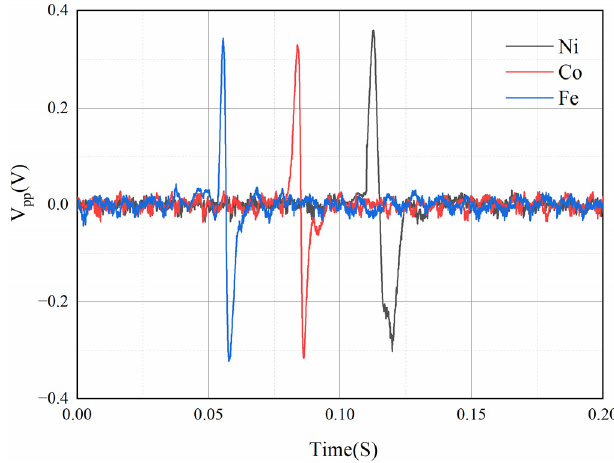
Figure 13. Induced voltage of three kinds of metals.